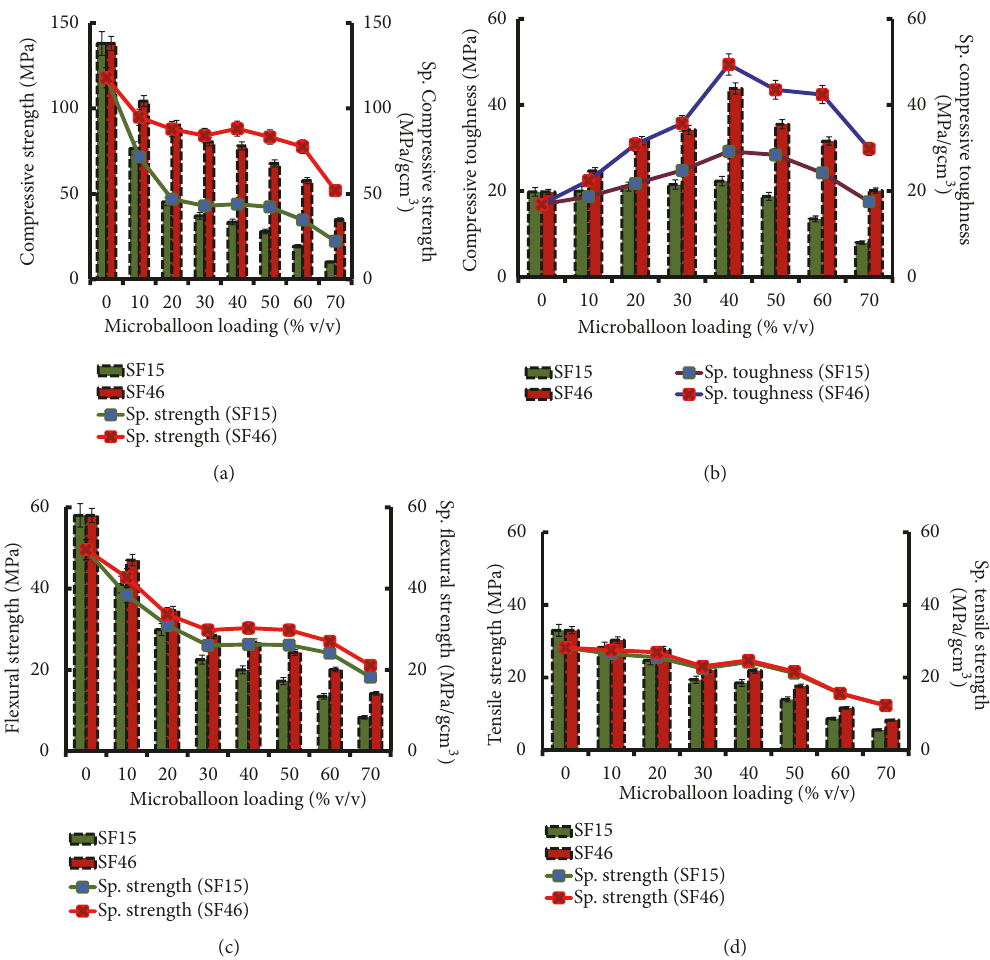
Figure 8: (a-b) Compressive, (c) flexural, and (d) tensile properties of epoxy syntactic foams containing different microballoons at varying loadings.